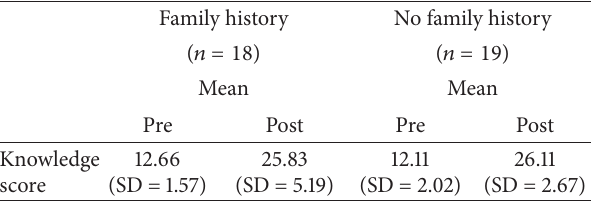
Table 2: Mean knowledge scores of pre- and